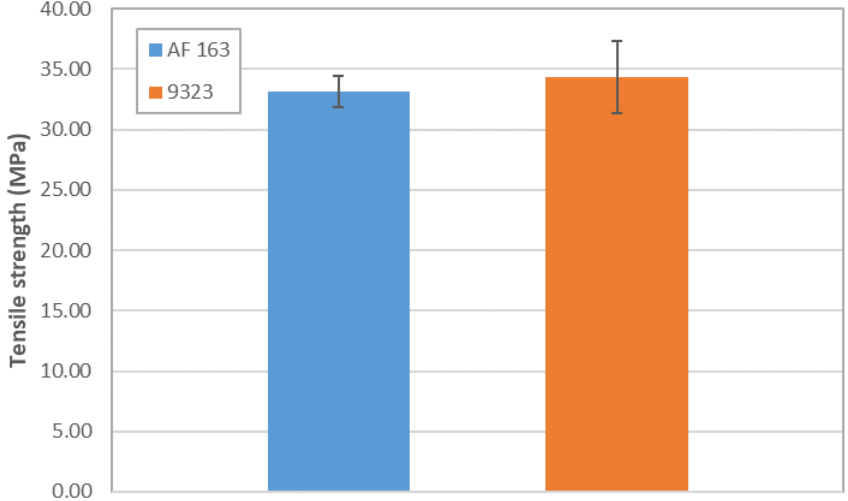
Figure 27. Results of TRAZ-BJ tests. Failure was always located in the composite adherends; hence values are representative of the T1100 out-of-plane tensile values are representative of the T1100 out-of-plane tensile strength.